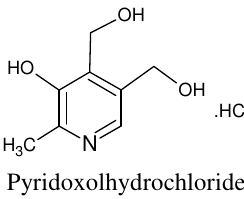
Figure 13. Structure of Pyridoxol